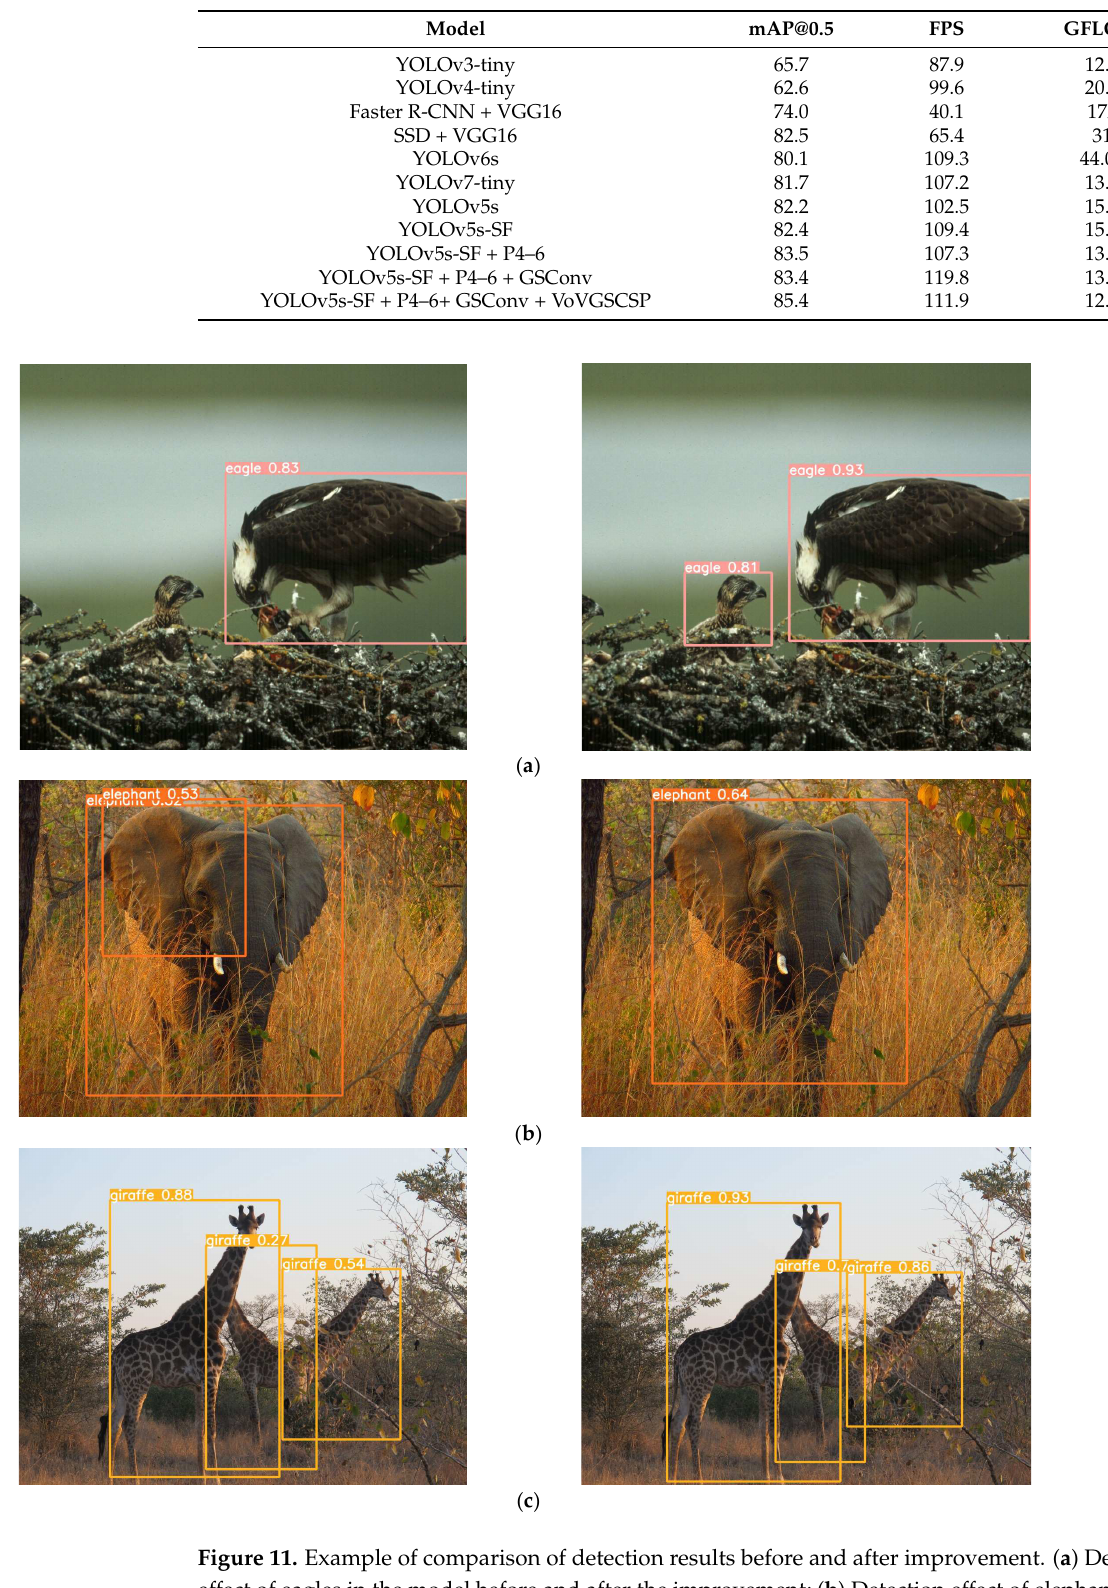
Table 6. Object detection model performance comparison.